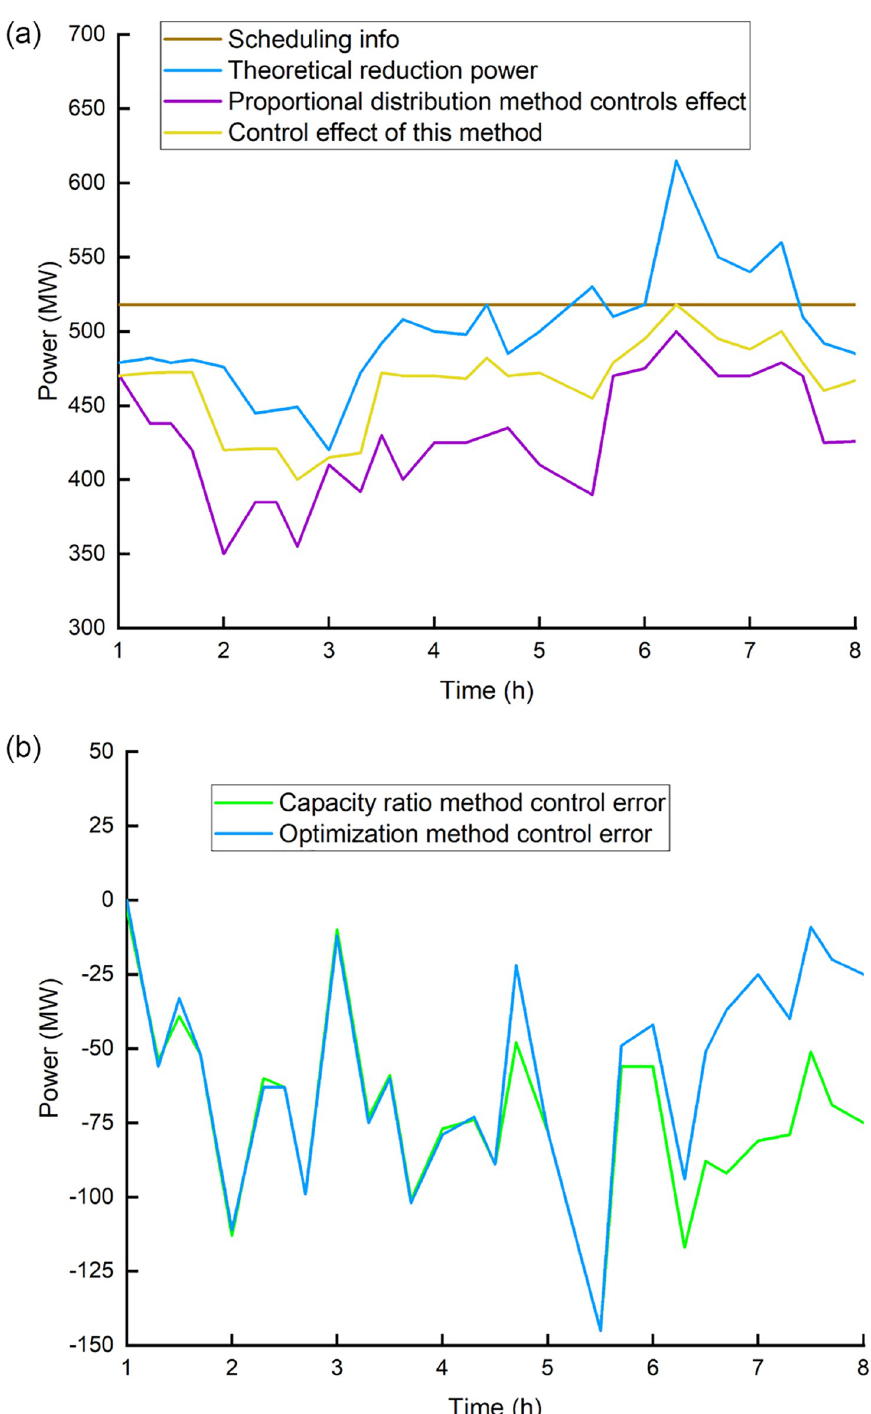
Fig 5. Comparison of the control effects of the two methods. (a) 1 st wind farm, (b) 2 nd wind farm, (c) 4 th wind farm.